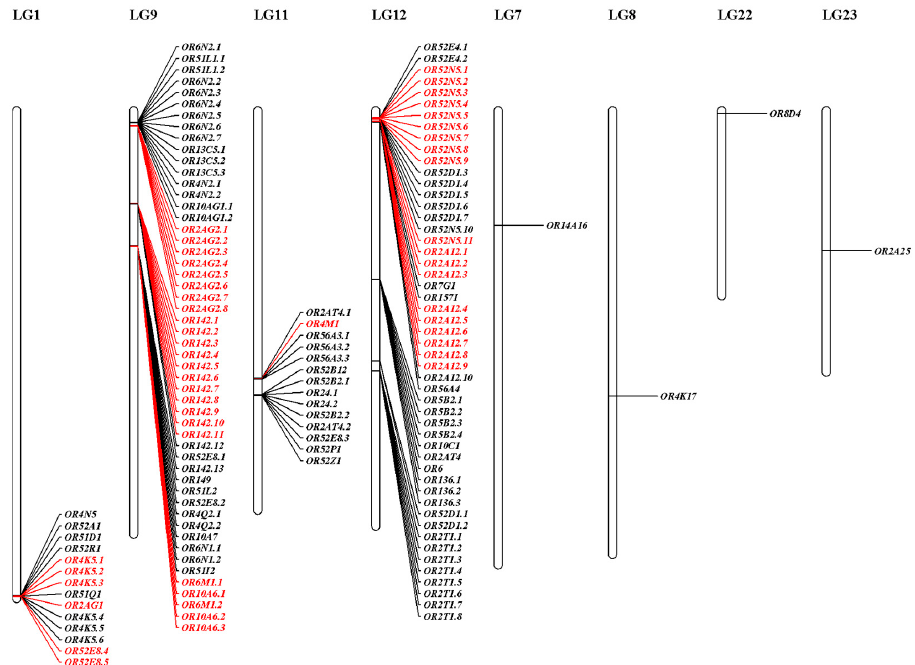
Figure 4. Chromosomal distribution of S. sihama OR genes. The majority of S. sihama OR genes were organized in seven clusters on four chromosomes. The other four OR genes were located on four chromosomes. The genes highlighted in red are expanded genes.